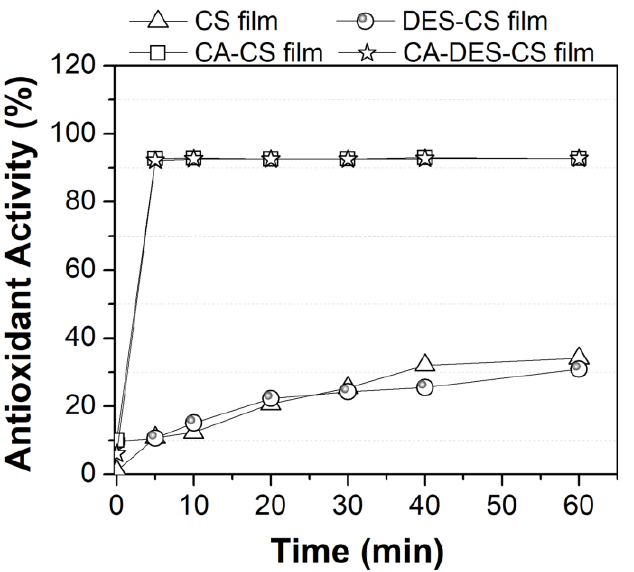
Figure 11. Antioxidant activity of a neat chitosan film (CS film), a chitosan film containing 10% v / v DES (DES-CS film), a mCLEAs-modified chitosan film with caffeic acid (CA-CS film), and a mCLEAs-modified chitosan film containing 10% v / v DES with caffeic acid (CA-DES-CS film).